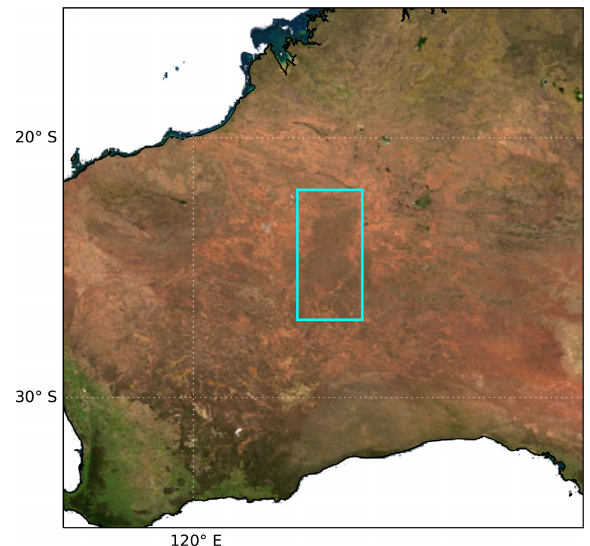
Figure 10. Map of the subregion in western Australia with homo- geneous land type used in a case study.